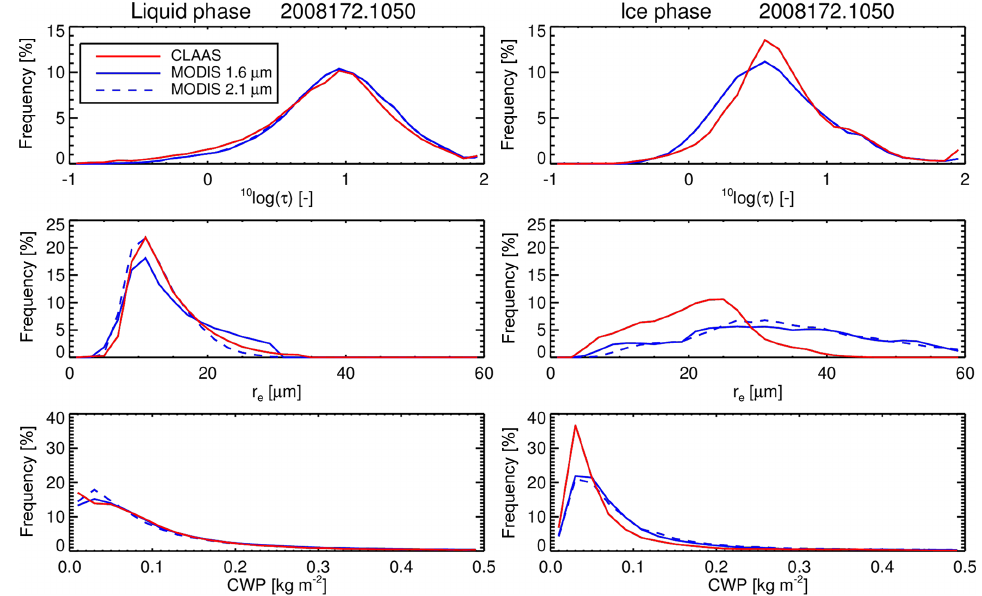
Figure 7. Histograms of CLAAS-2 and MODIS COT (top), REF (middle) and CWP (bottom) for the selected MODIS granule on 20 June 2008. The left panels are liquid clouds and the right panels are ice clouds. Only pixels for which both products agree on CPH are included. For MODIS the standard and PCL (partly cloudy) retrievals were combined, and results are shown for retrievals with two different wavelength bands (1.6 and 2.1µm). Note that differences between MODIS 1.6 and 2.1µm based on COT are small. Hence, the solid and dashed blue lines in the top panels cannot be